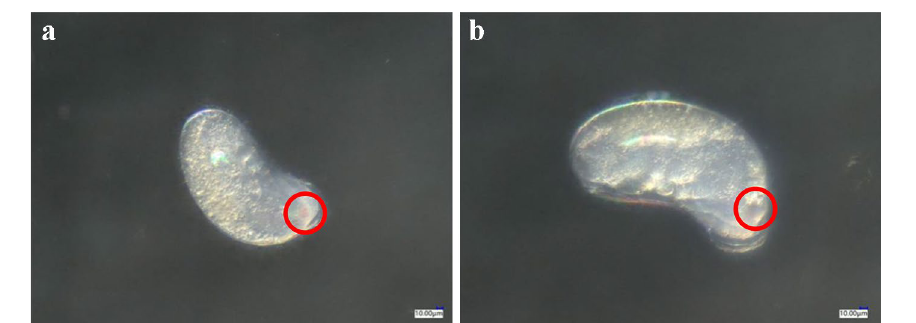
Figure 3. The effect of spirotetramat on external morphology of isolated 24-h-old eggs of F. occidentalis . ( a ) Normally developing 24-h-isolated eggs in the control group; ( b ) 24-h-old eggs after spirotetramat treatment.